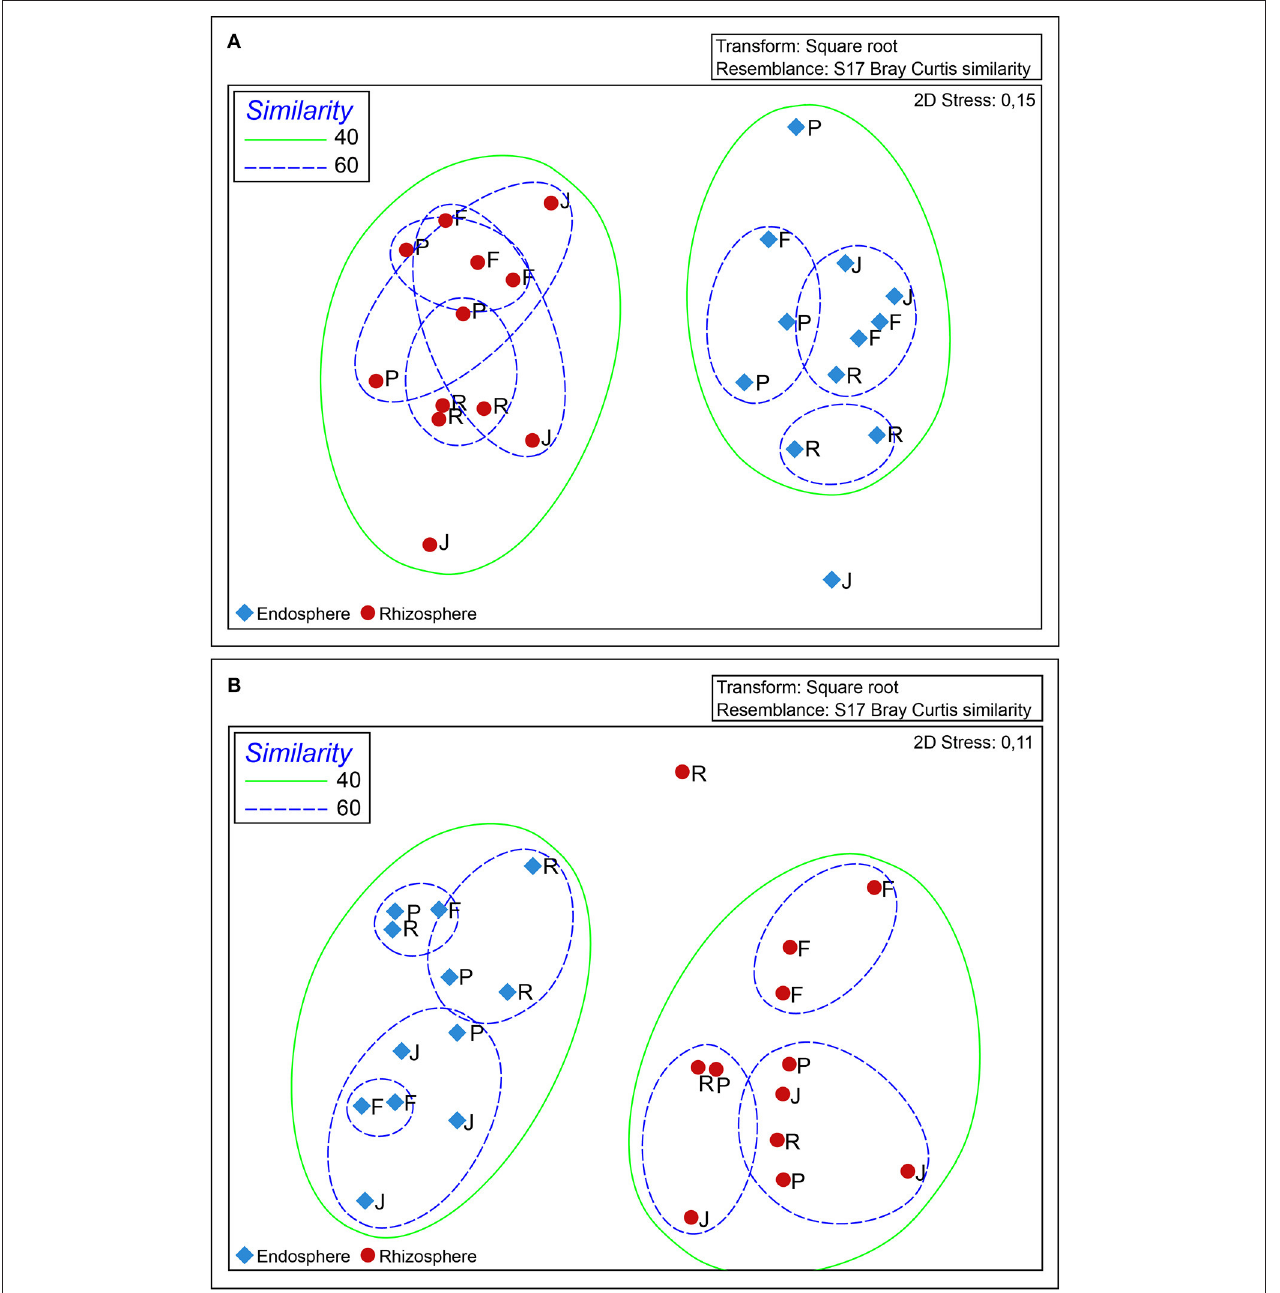
FIGURE 4 | Non-metric multidimensional scaling (nMDS) analysis of DGGE fingerprinting of 16S rRNA (A) and nifH (B) analysis generated by Primer v6 software (http://www.primer-e.com) with the Bray-Curtis similarity index, 5% significance level, and < 0.1 stress values. Red and blue shapes represent rhizosphere and root endosphere, respectively. Samples labelled as F, P, J and R correspond to Feña, Patras, Joker and Rocky wheat cultivars,